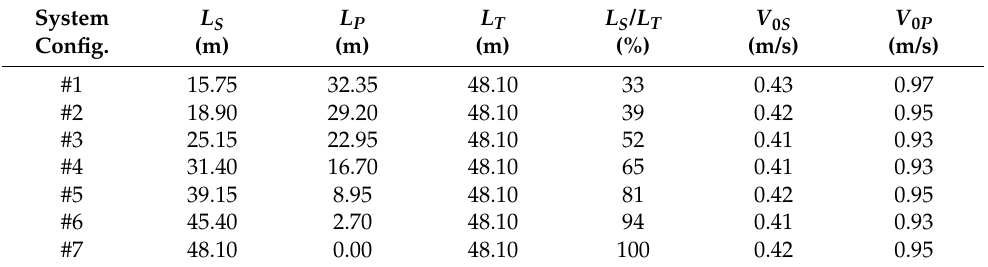
Table 1. Dimensions of the pipeline system in each configuration and steady state flow parameters.